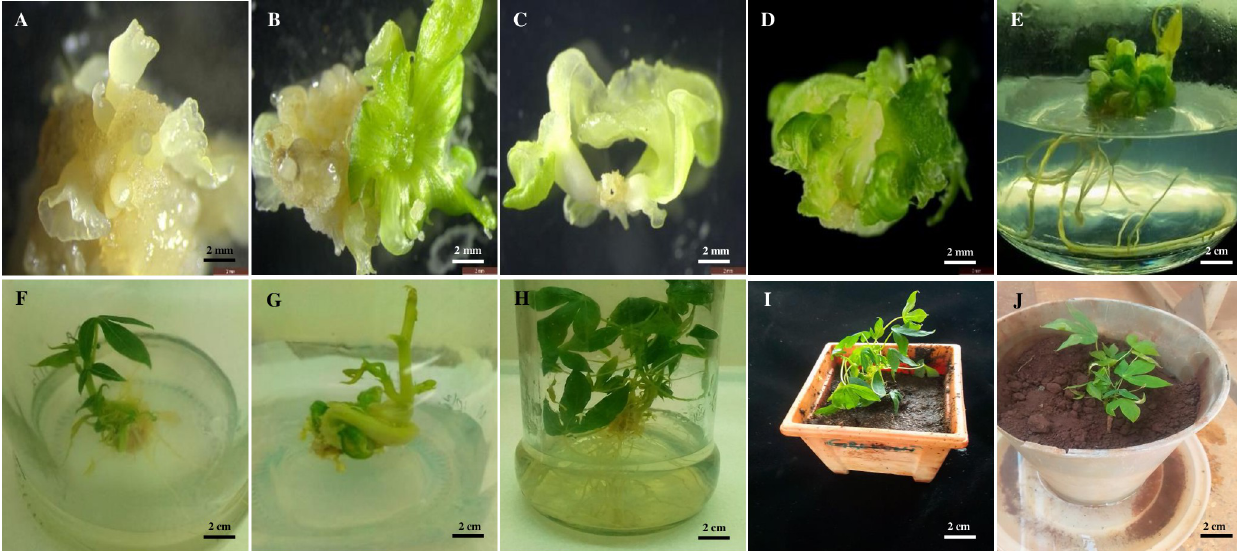
Fig 4. Embryo maturation, shoot and root induction. A. cotyledonary embryos after 14 days of culture in maturation media. B. Greening cotyledonary embryos after 3 days of culture in desiccation medium. C. Greening cotyledonary embryos with defined shoot and root apices. D. Wholly greening leafy embryogenic calli. E. Rooting plantlet with stunted shoot elongation. F. Rooting plantlet with elongating shoot. G. Shooting embryogenic calli in 0.4 mg/l BAP. H. Rooted plantlet after one month of culture in MM medium. I. Hardening plantlet in peat moss. J . plantlet growing in soil in the green house.